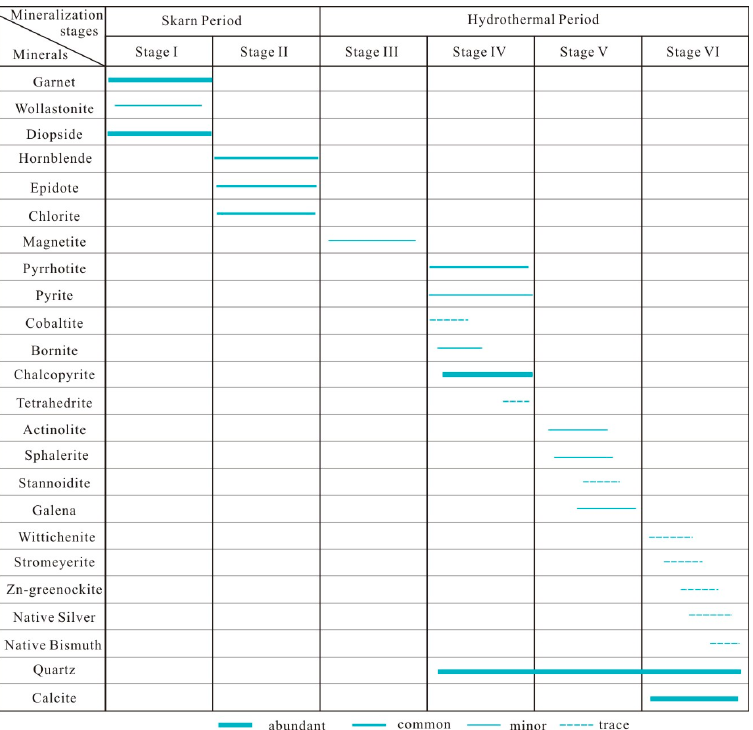
Figure 4. Paragenetic sequence of the Saishitang Cu deposit.